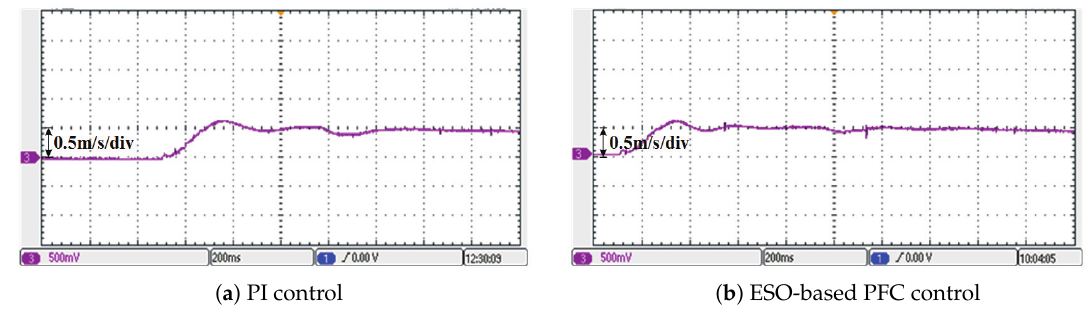
Figure 7. Speed response